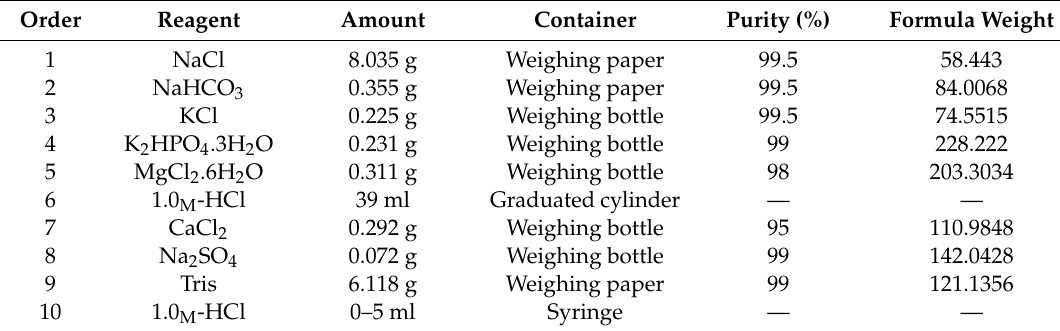
Figure 4. Jars containing specimens in Simulated Body Fluid (SBF) with heating filament for maintaining temperature. Table 3. Order amounts, weighing containers, purities, and formula of reagent for preparing 1000 mL SBF [20].